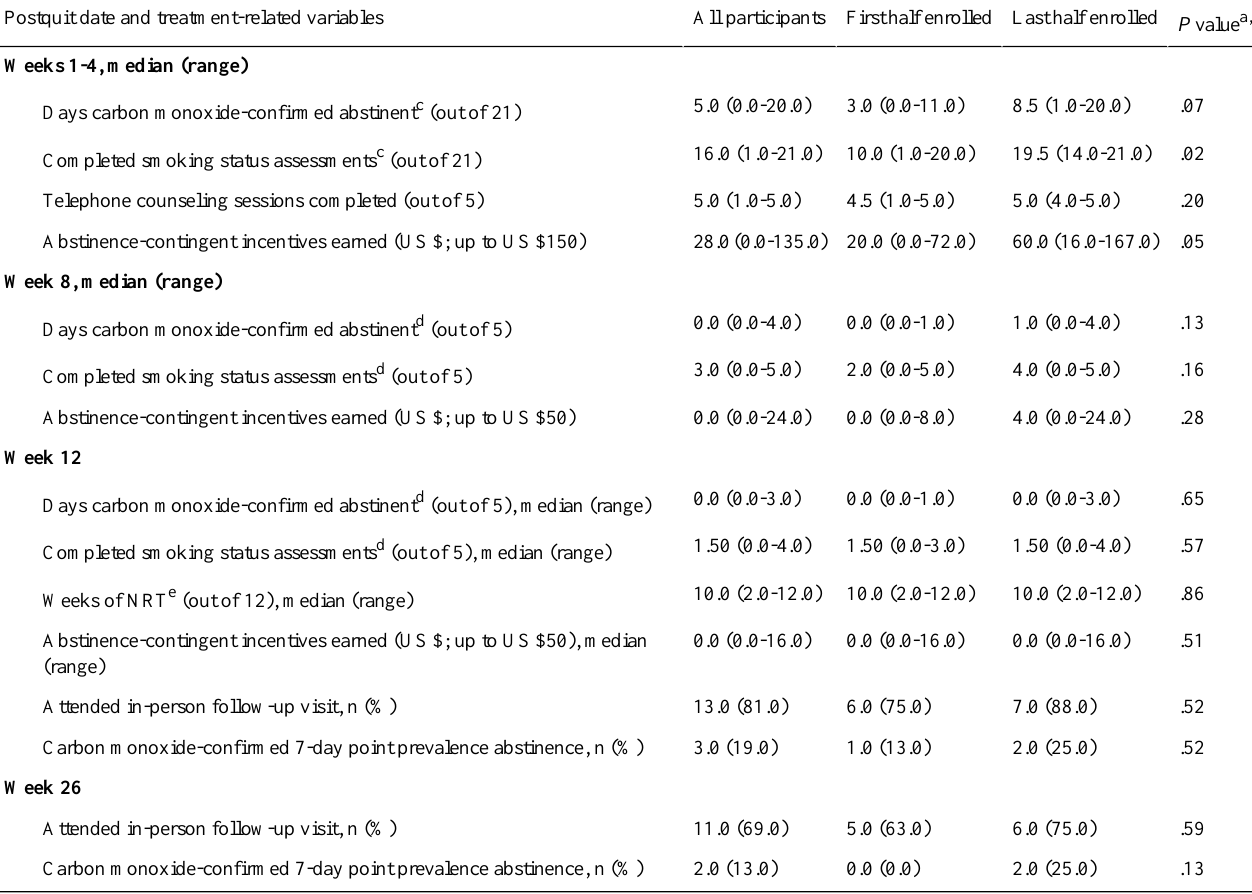
P value a,b Last half enrolledFirst half enrolledAll participantsPostquit date and treatment-related variables